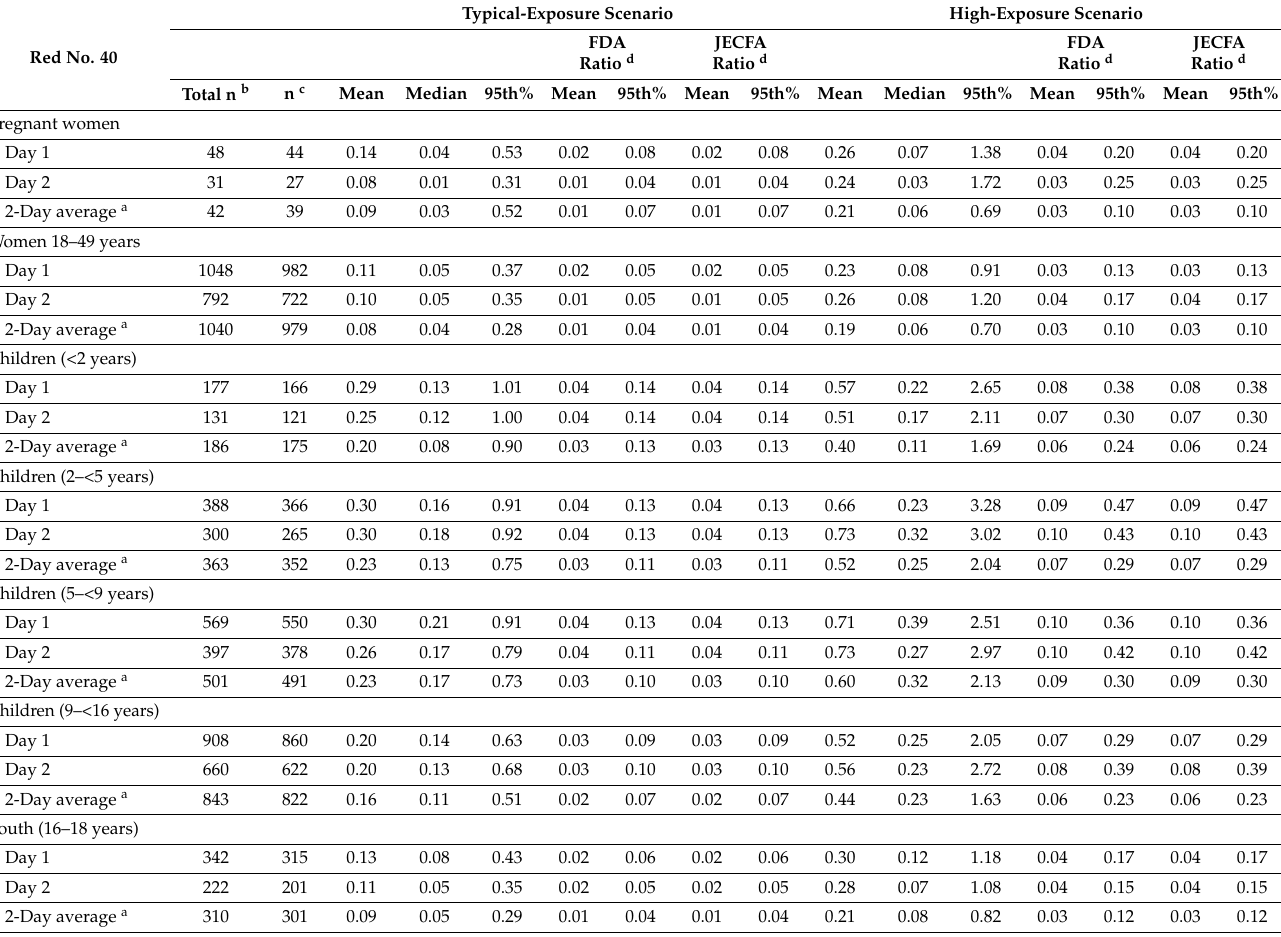
Table 2. Single-day and two-day average FD&C Red No. 40 exposure estimates (mg/kg/day) and hazard ratios among pregnant women, women of childbearing age, and children of various ages who consumed at least one food containing Red No.